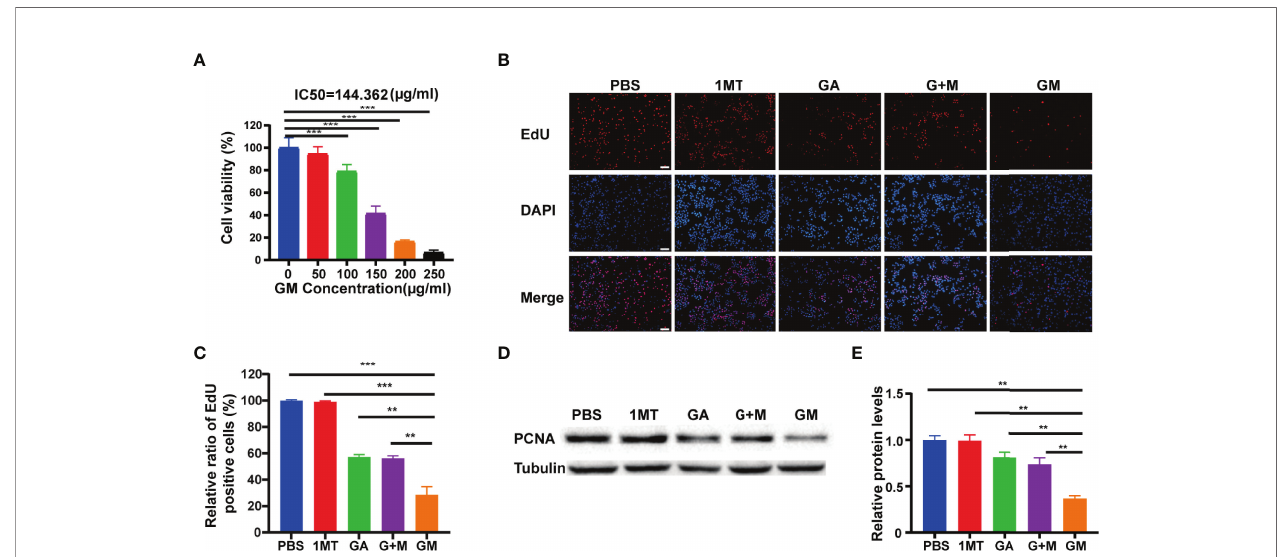
FIGURE 1 | GA-1MT (GM) inhibited the proliferation of B16F10 cells in vitro . (A) Cell viability of B16F10 cells after culture with various concentrations. (B) Fluorescence images of B16F10 cells stained with EdU (red) and DAPI (blue) after different treatments (scale bar: 100 µm). (C) Quantitative analysis of EdU- positive cells after each treatment. (D) Western blotting to indicate the expression levels of PCNA in B16F10 cells from different groups. (E) Quantitative analysis of relative protein levels after various treatments. Data are presented as means ± SD, n = 3, **p < 0.01, ***p <